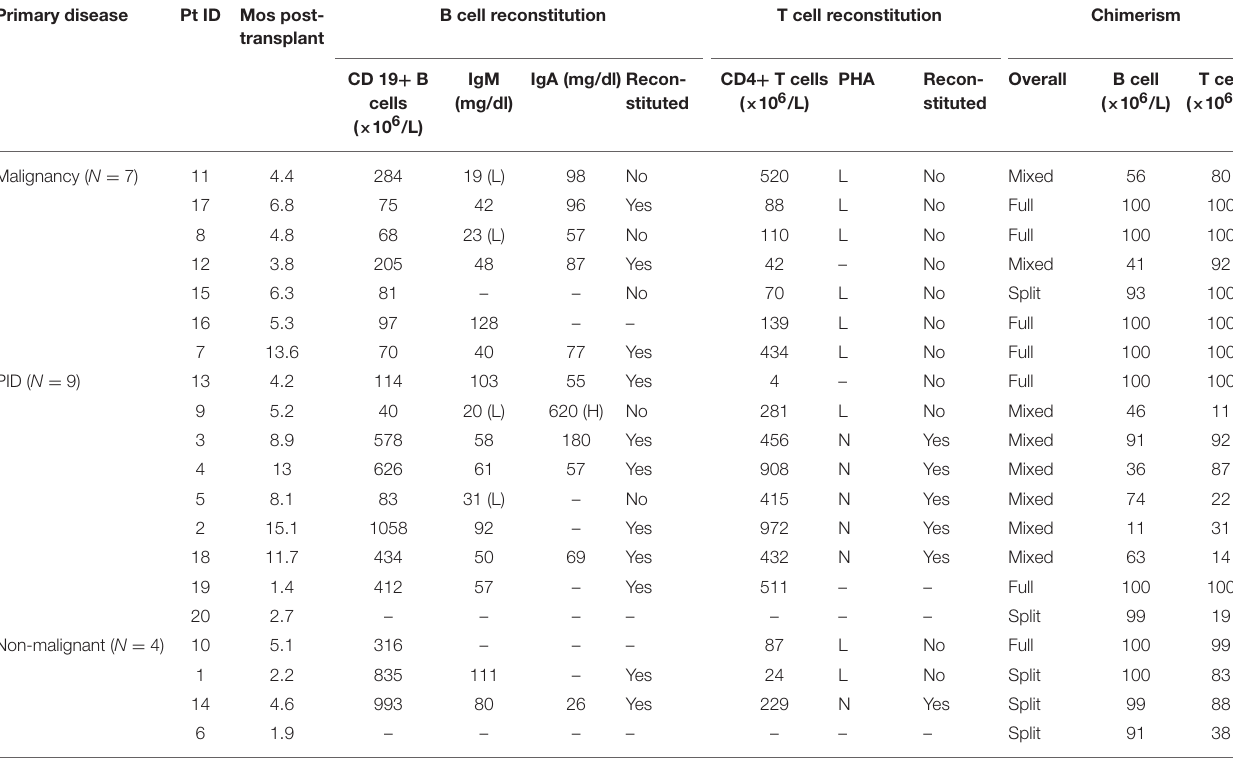
TABLE 2 | Immune reconstitution data of 20 subjects with post-transplant AIC stratified by primary disease. Primary disease